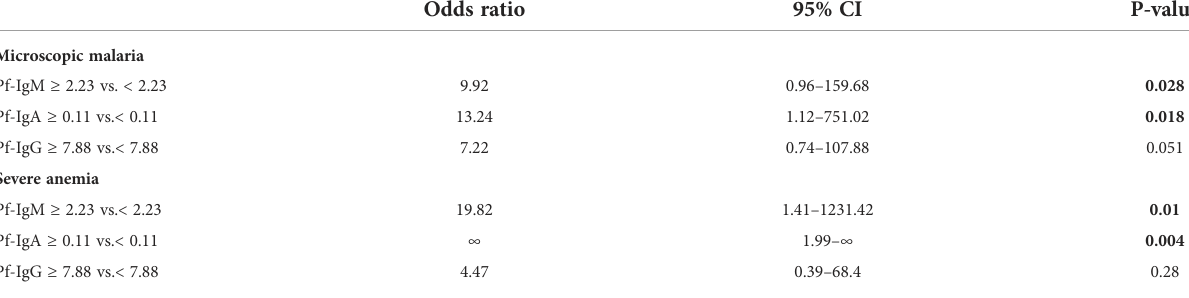
Bold values indicates signi fi cant p-values ( ≤ 0.05). Inoddsratioanalysis,whenthecomparisongrouphas0casesitissettoin fi nitygiventhataratiowherethedenominatoris0cannotbecalculated.Notethatallcasesofsevereanemiaarein the IgA>0.11